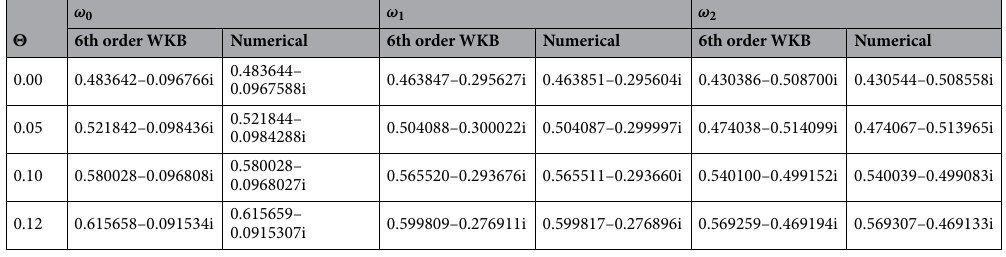
Table 2. QN frequencies for l = 2 .